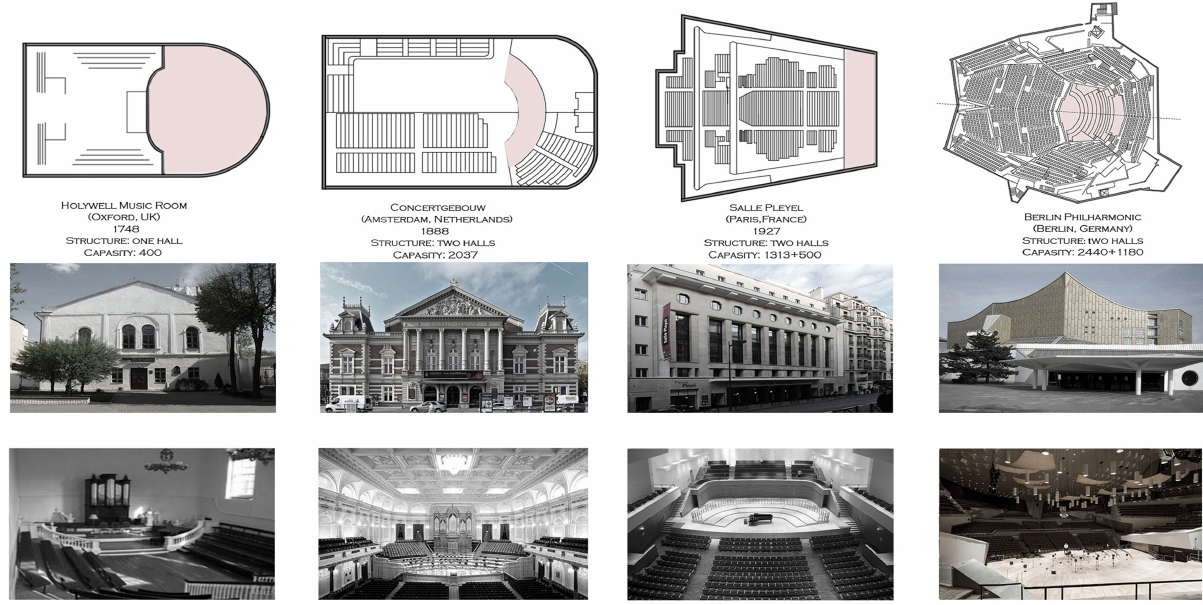
Figure 1: The concert halls before the Berlin